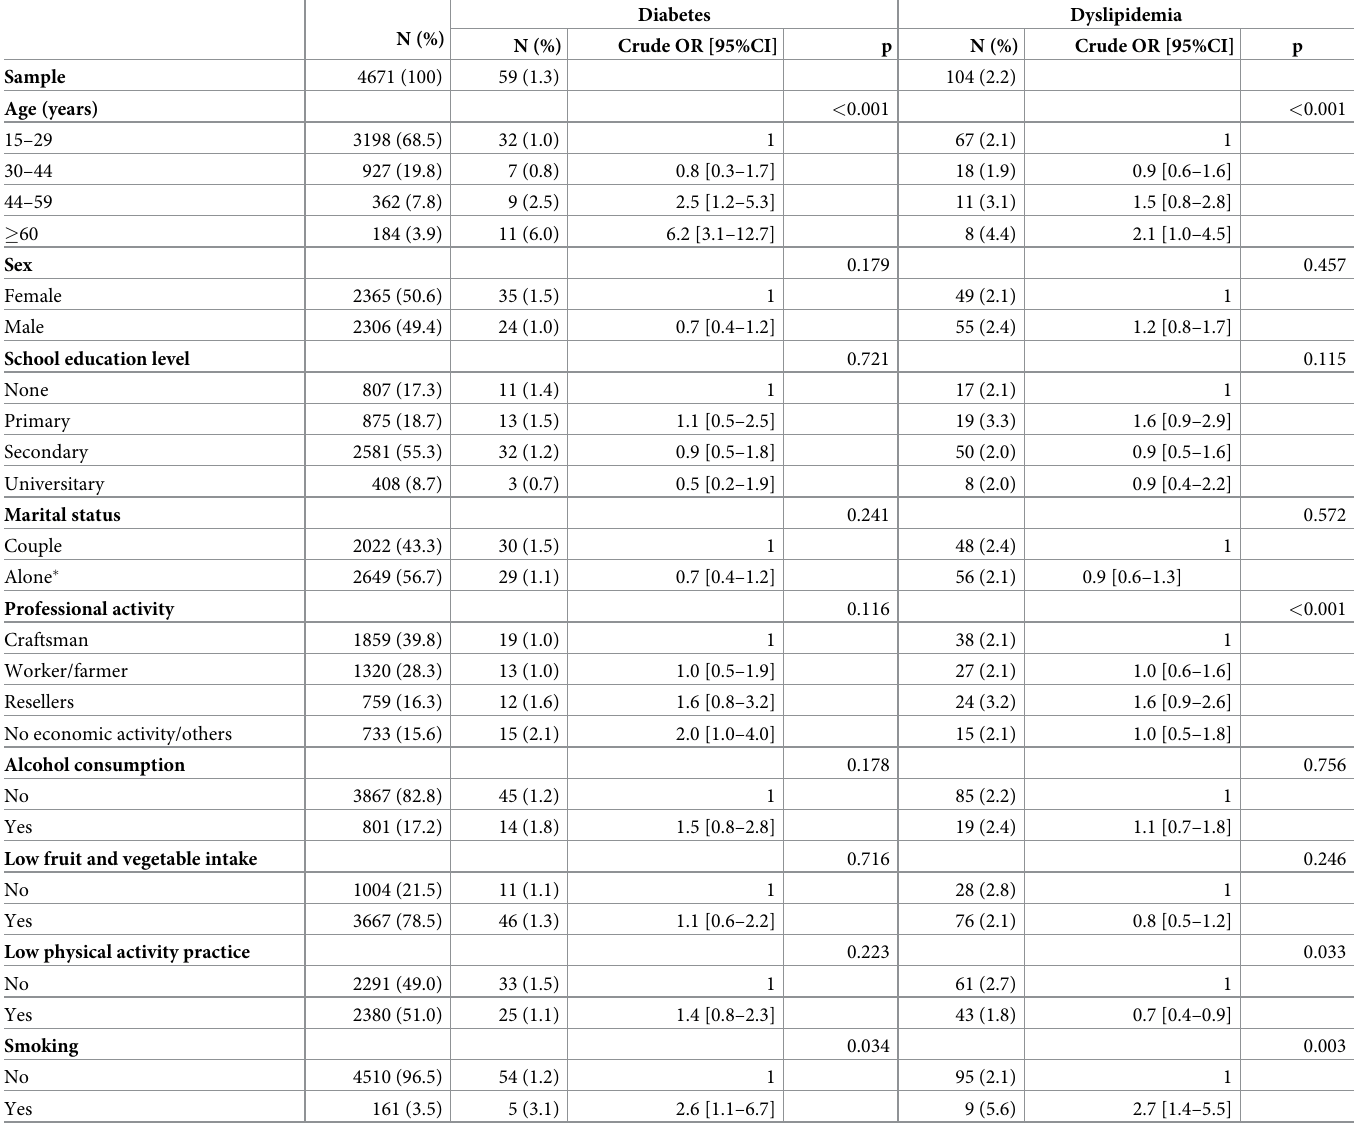
Table 2. Prevalence of diabetes mellitus and dyslipidemia according to socio-demographic and to behavioral